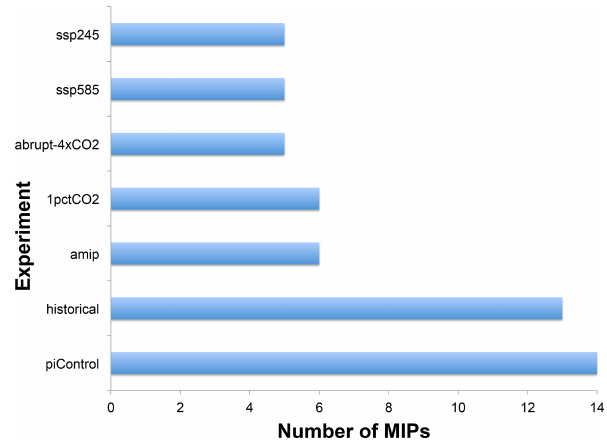
Figure 7. The most-used CMIP6 experiments in terms of the num- ber of model inter-comparison projects (MIPs) to which they con-